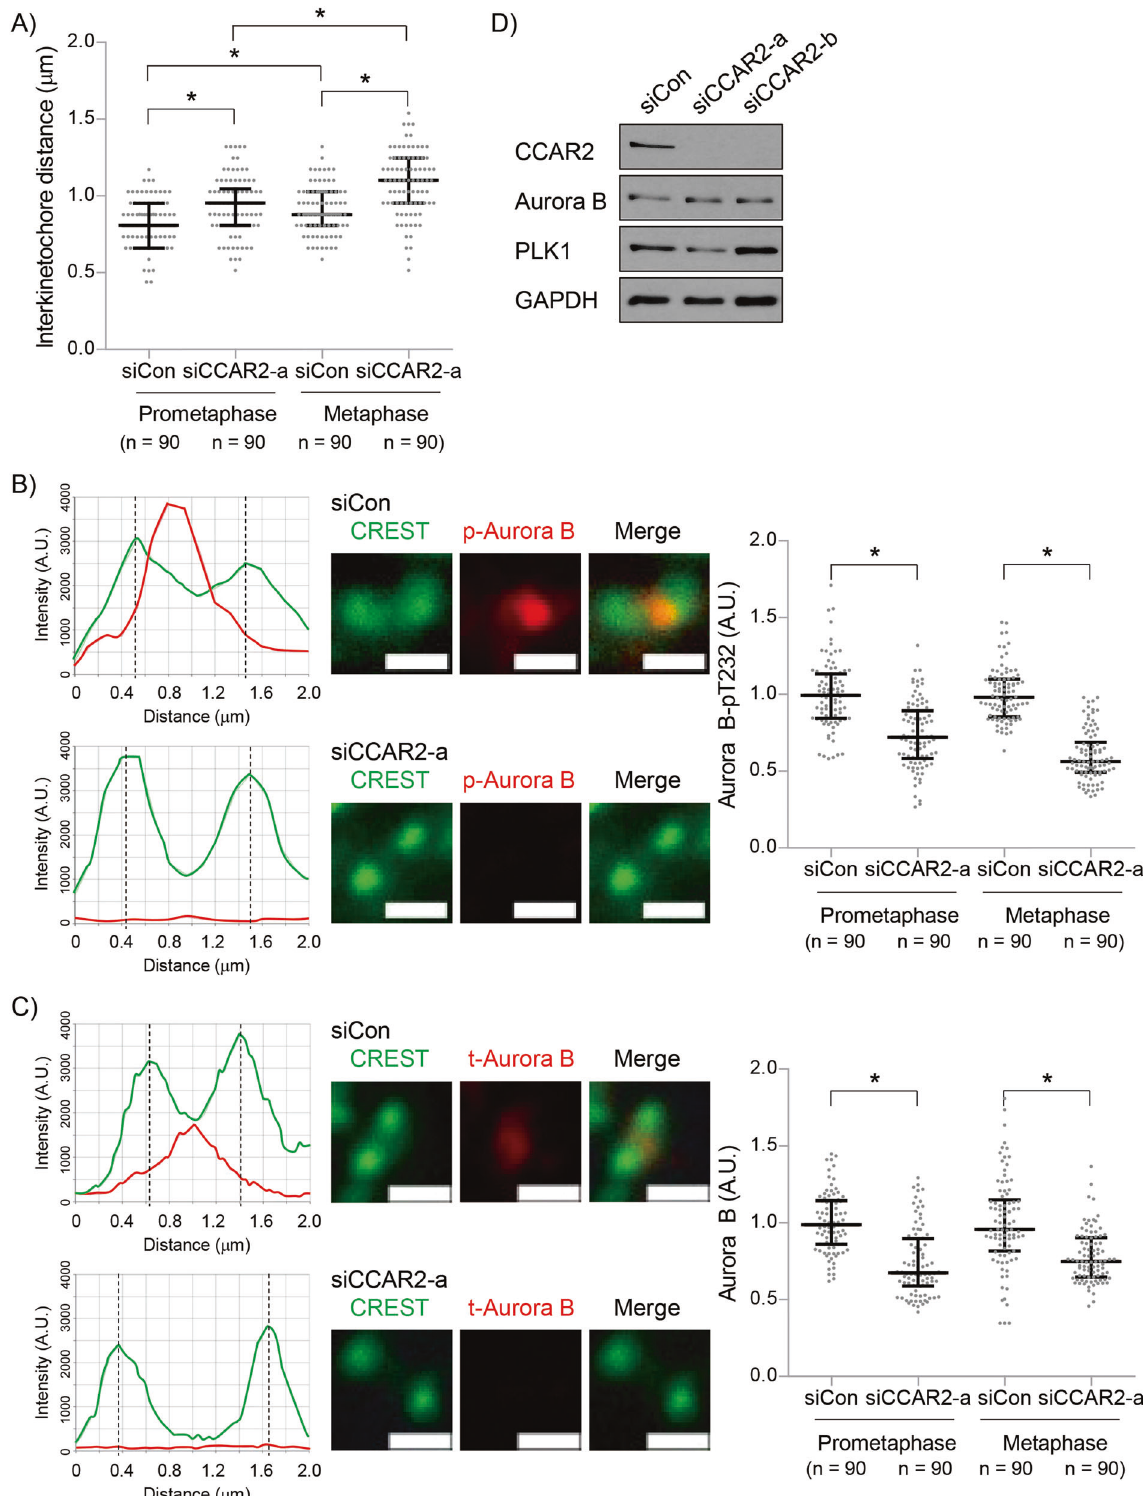
Fig. 4 CCAR2 de fi ciency induces inactivation of Aurora B at prometaphase and metaphase. A − C Asynchronous cells were stained with Hoechst, CREST, and anti-Aurora B-pT232 or anti-Aurora B antibodies. In total, 90 kinetochores from 30 cells were examined in three separate experiments ( N = 3, n = 90). A The distance between kinetochores labeled with CREST was measured at prometaphase and metaphase, and presented as a dot plot. The fi rst and third bars are the 25th and 75th percentiles, respectively, and the second bar is the median. * p < 0.05, signi fi cantly different between multiple groups (one-way ANOVA). B , C Fluorescence intensity of kinetochore-associated Aurora B-pT232 and Aurora B in siCCAR2-a cells was normalized to that of siCon cells at prometaphase and metaphase. * p < 0.05, signi fi cantly different from corresponding siCon cells (two-sided unpaired Student ’ s t-test); A.U., arbitrary units; scale bar, 1 μ m. D The expression of each protein in asynchronous cells was con fi rmed by western blotting. Cell Death and Disease (2022)